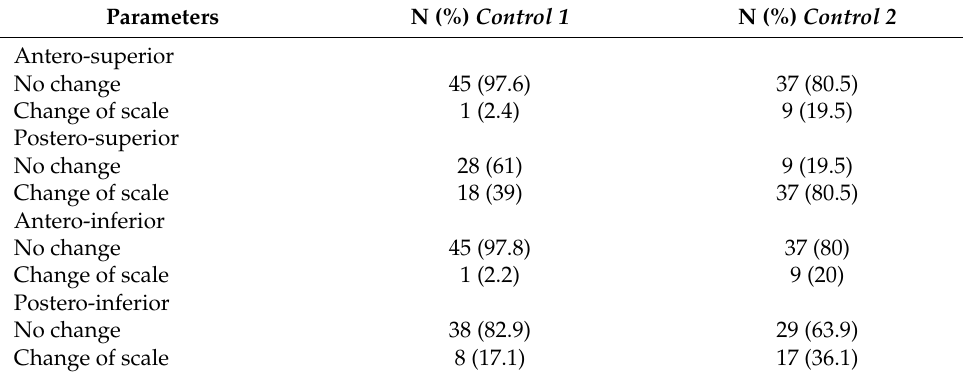
Table 5. New wear scale for intraoral